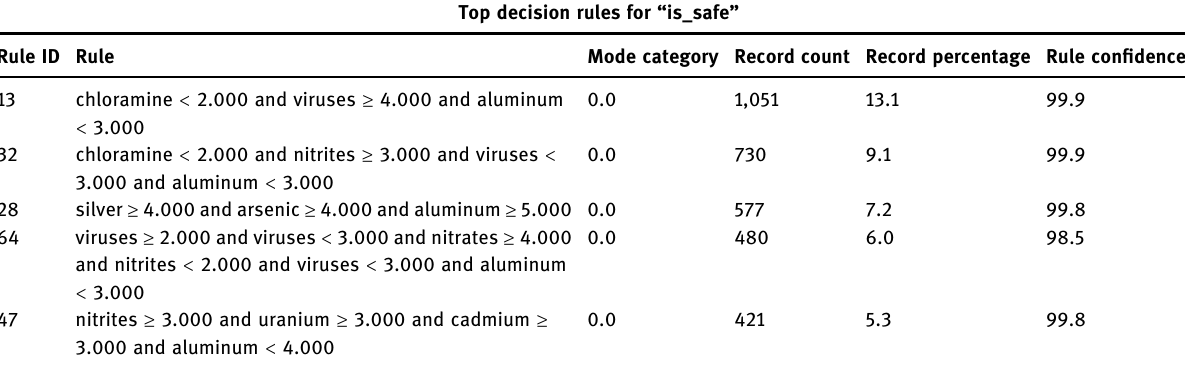
Top decision rules for “ is_safe